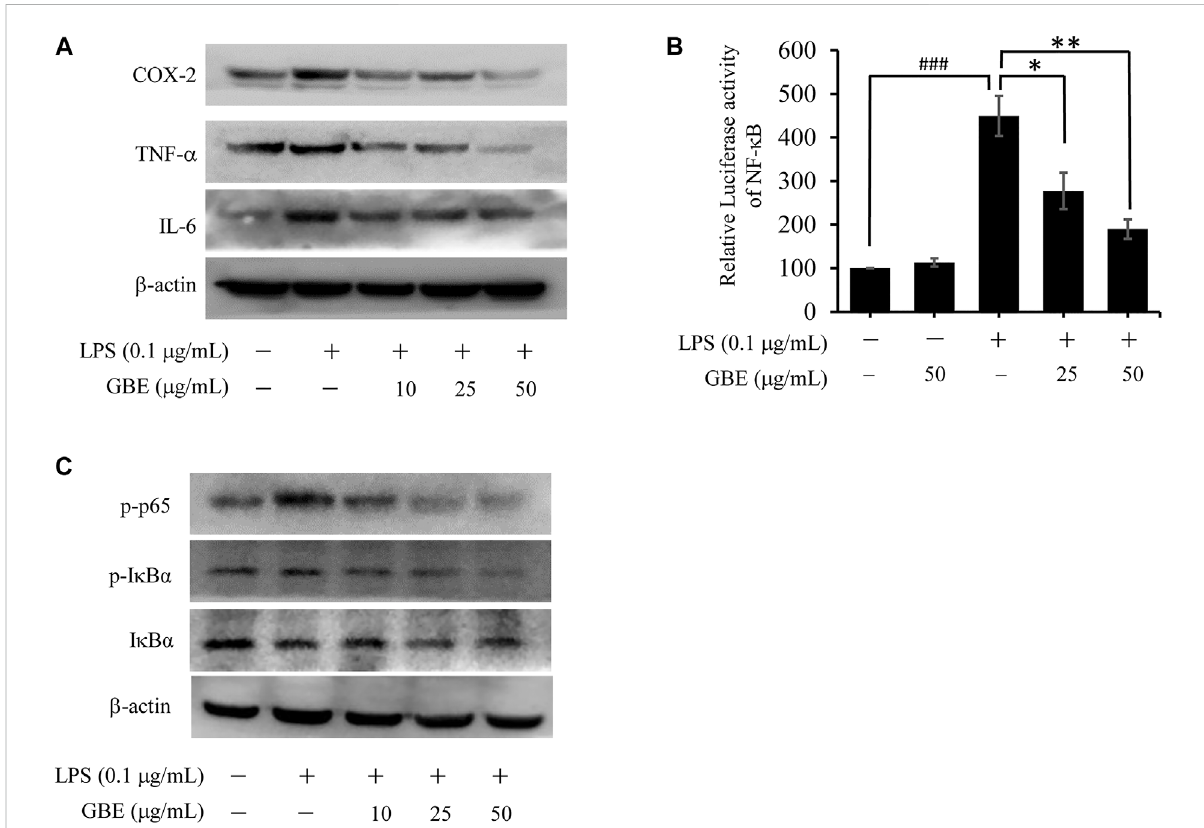
FIGURE 3 Effects of GBE on the expression of in fl ammatory cytokines and NF- κ B pathway in LPS-stimulated BV-2 cells. BV-2 cells were pre-treated with GBE (25 and 50 µg/ml) for 1 h, and then incubated with or without LPS (0.1 µg/ml) for 24 h. (A) The expression of TNF- α , IL-6, and COX-2 was analyzed using western blotting in BV-2 cells. (B) 293T cells were cotransfected with pNF κ B-luc with Renilla luciferase reporter (as internal control) for 24 h, and then pre-treated with GBE (25 and 50 µg/ml) for 1 h; thereafter, the cells were incubated with or without LPS (0.1 µg/ml) for 24 h. Luciferase activity was determined using a dual-luciferase reporter assay system (* p < 0.05, ** p < 0.01, GBE treatment vs. LPS-stimulated positive control; ### p < 0.001, LPS-stimulated positive control vs. vehicle control groups). (C) The expression of p-p65, p-I κ B α , and I κ B α were analyzed using western blotting in BV-2